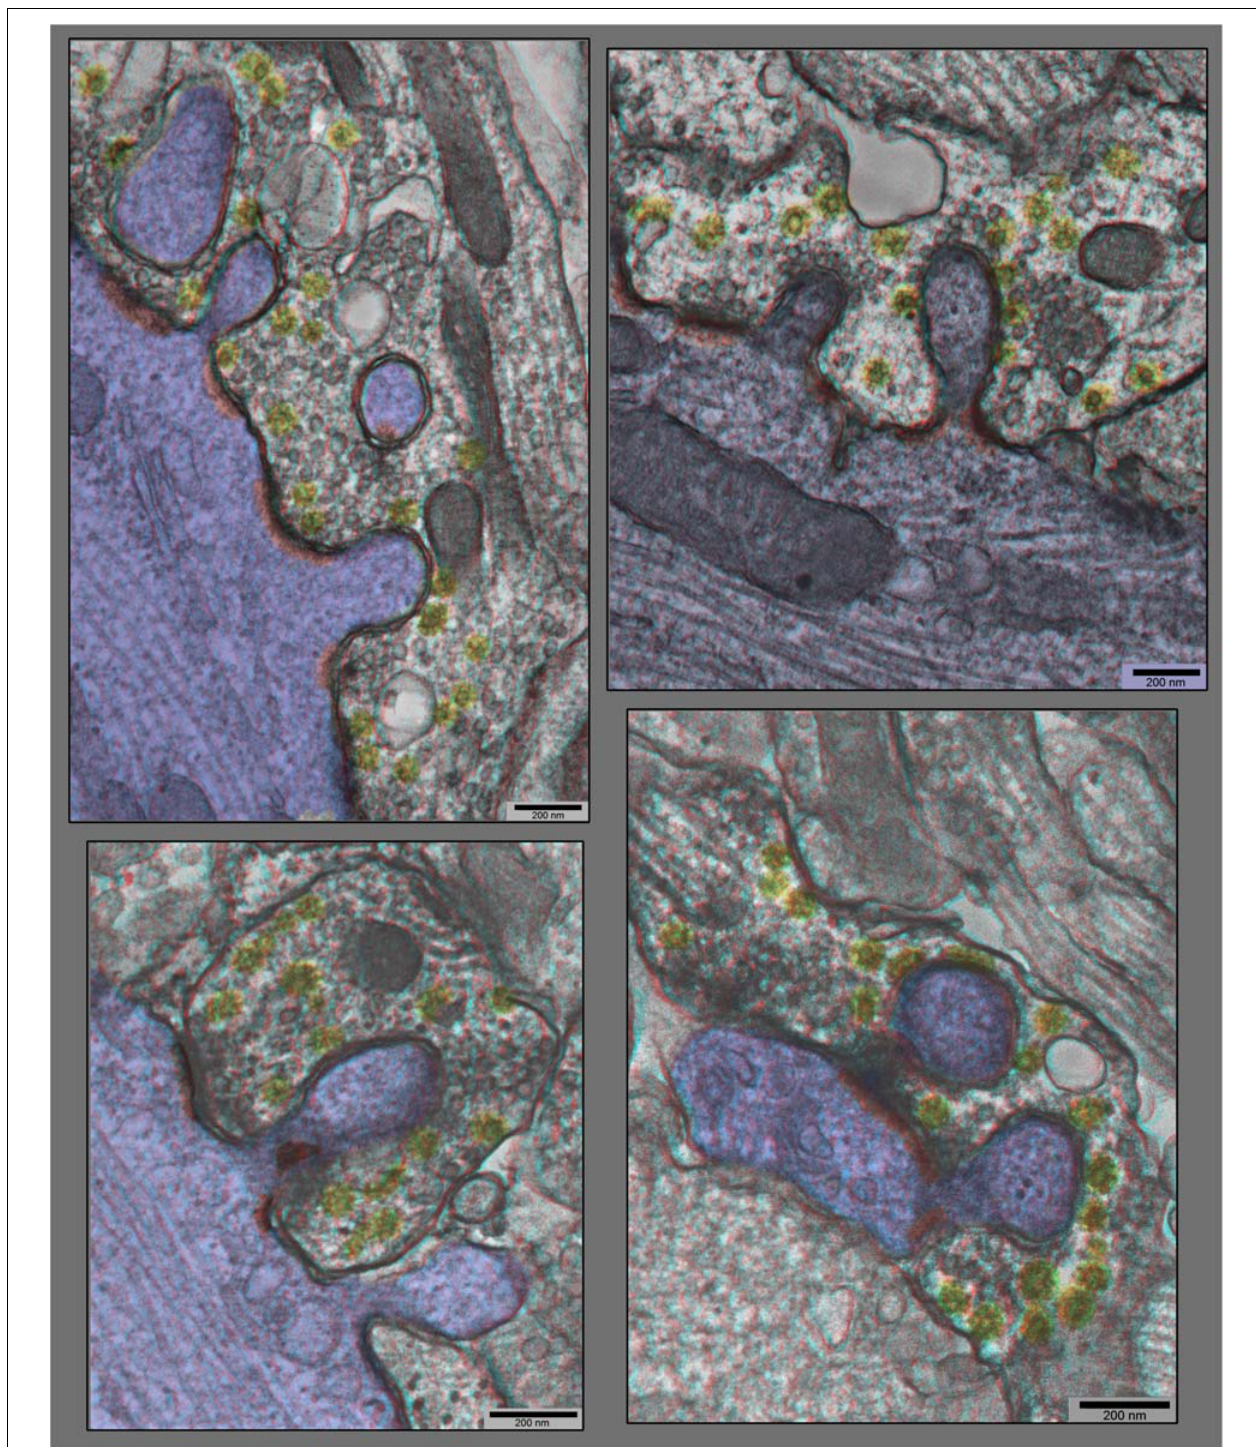
FIGURE 6 | “Anaglyph” 3D views of additional synapses in hippocampal cultures exposed to 0.1 mM La +++ for 10–20 min at 37 ◦ C), from plastic blocks that were cut thicker (at 120–150 nm), and photographed at + 20 ◦ and –20 ◦ of tilt in the EM, then superimposed to make the 3–D “anaglyphs”. These require red/green “anaglyph” glasses to fully appreciate, but even without, it is still readily apparent that synaptic vesicles are relatively depleted, coated vesicles are relatively abundant (yellow), and postsynaptic densities are relatively fragmented (PSDs highlighted in red, and dendrites highlighted in blue).